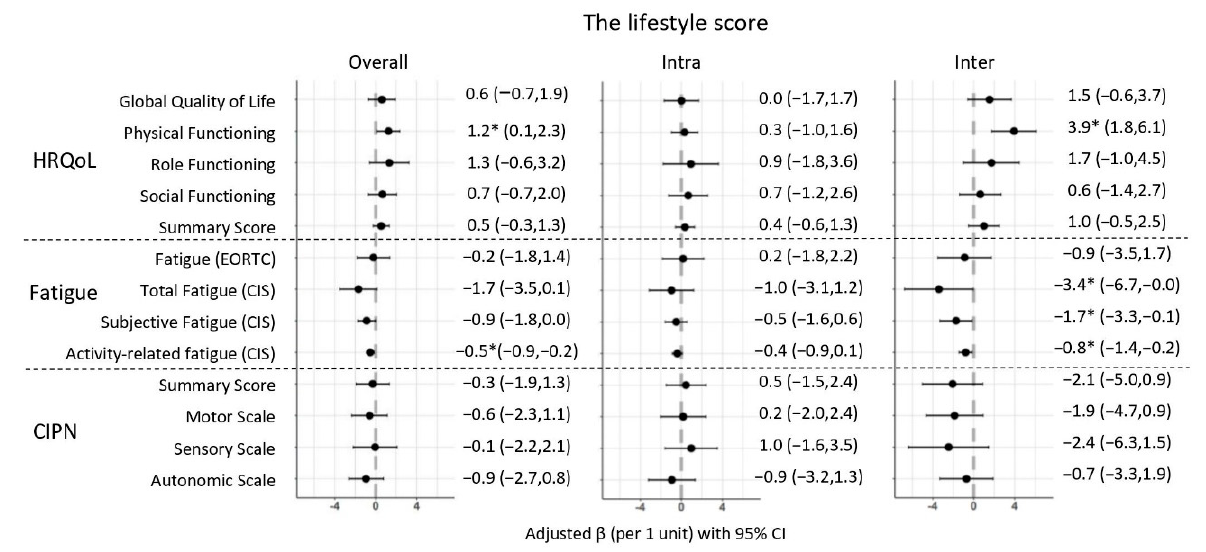
Figure 1. Forest plots showing the confounder-adjusted beta’s ( β ) and 95% confidence intervals (CI) for the overall longitudinal, intra-, and inter-individual associations of the lifestyle score in relation to health-related quality of life, fatigue, and chemotherapy-induced peripheral neuropathy in stage I-III colorectal cancer survivors followed-up from 6 weeks up to 24 months post-treatment. Model adjusted for sex (male/female), age at enrolment (years), co-morbidities (0, 1, ≥ 2), education (low, medium, high), chemotherapy (yes/no), total energy intake (kcal/day), stoma (yes/no), smoking status (current/former/never), and time since diagnosis (months). * Indicates statistically signifi- cant associations ( p < 0.05) between the lifestyle score and health-related quality of life, fatigue and CIPN outcomes. Results exploring the influence of the individual recommendations on observed associations for the lifestyle score (Table 3) showed both attenuated and inflated associations for HRQoL and fatigue. We did not explore this in CIPN because no overall associations were found. When additionally adjusted for the physical activity subscore (both MVPA and sedentary behaviour), longitudinal associations attenuated and were all non-significant (e.g., physical functioning and activity-related fatigue). When the lifestyle score was additionally adjusted for the alcohol subscore, however, associations with all HRQoL and fatigue outcomes were inflated and became statistically significant. The lifestyle score additionally adjusted for alcohol was statistically significantly as- sociated with better global QoL (1.9; 0.6,3.3), physical functioning (2.6; 1.4,3.8), role functioning (3.3; 1.3,5.3), and social functioning (2.0; 0.5,3.4), and with less fatigue (EORTC: − 1.9; − 3.6, − 0.2),